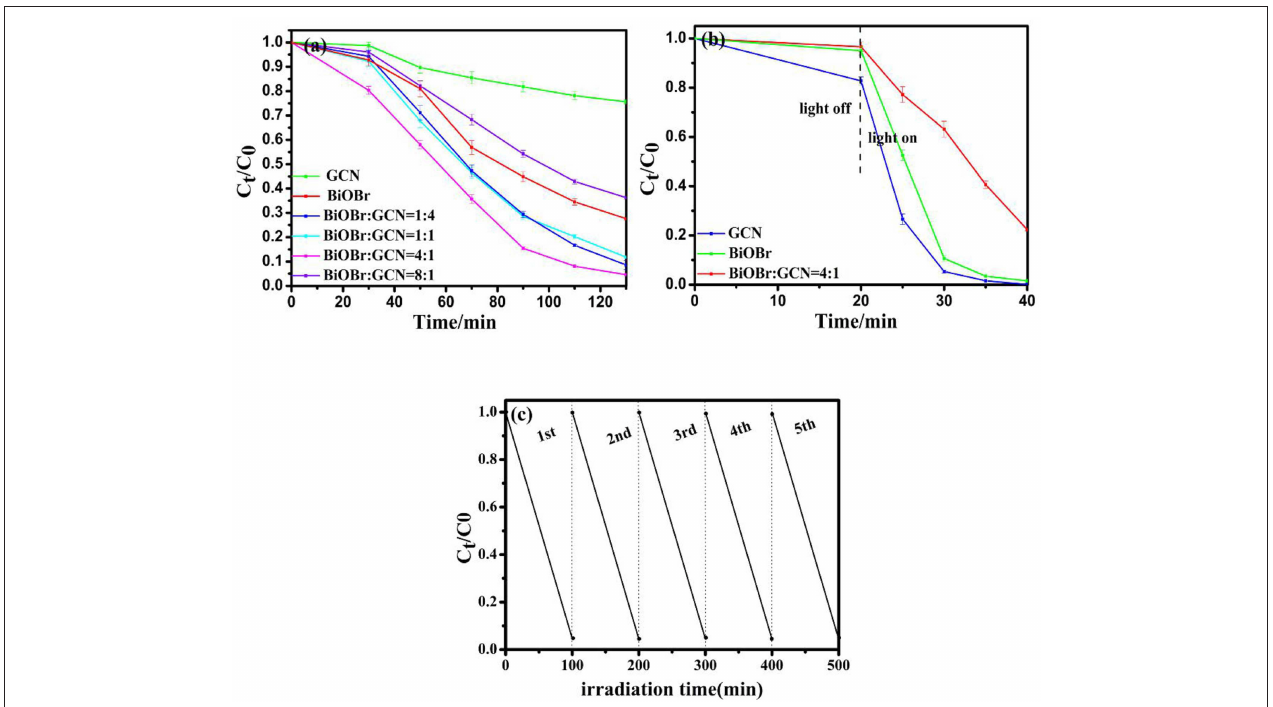
FIGURE 8 | Degradation of (a) MO and (b) RhB over pure BiOBr, g-C 3 N 4 and BiOBr-g-C 3 N 4 composites; (c) Recycling tests of BiOBr-g-C 3 N 4 -4:1 photocatalyst on the degradation of